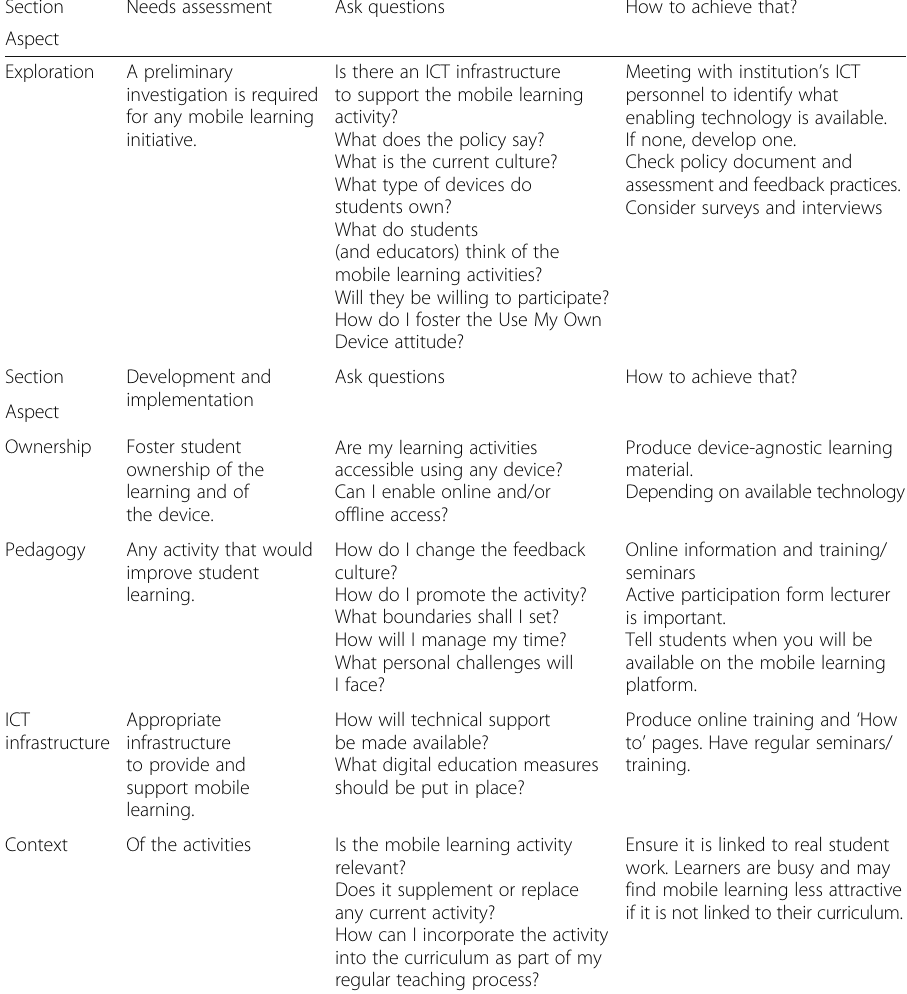
Table 1 Example of decision-making exercise using MLFAF